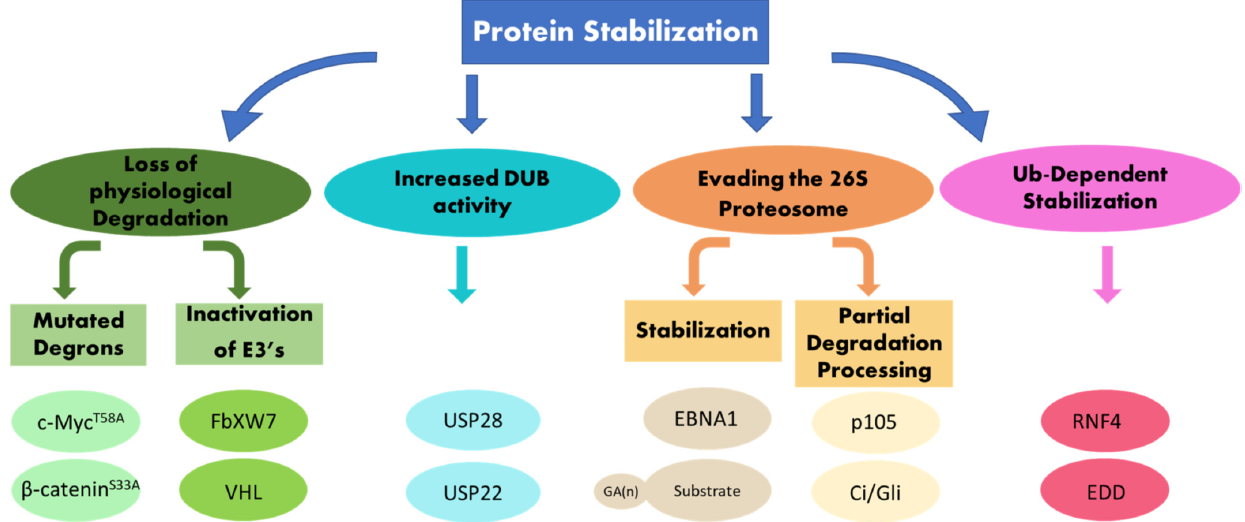
Figure 1. Mechanisms of protein stabilization. Schematic diagram for mechanisms resulting in protein stabilization that are discussed in this review, see text for details.